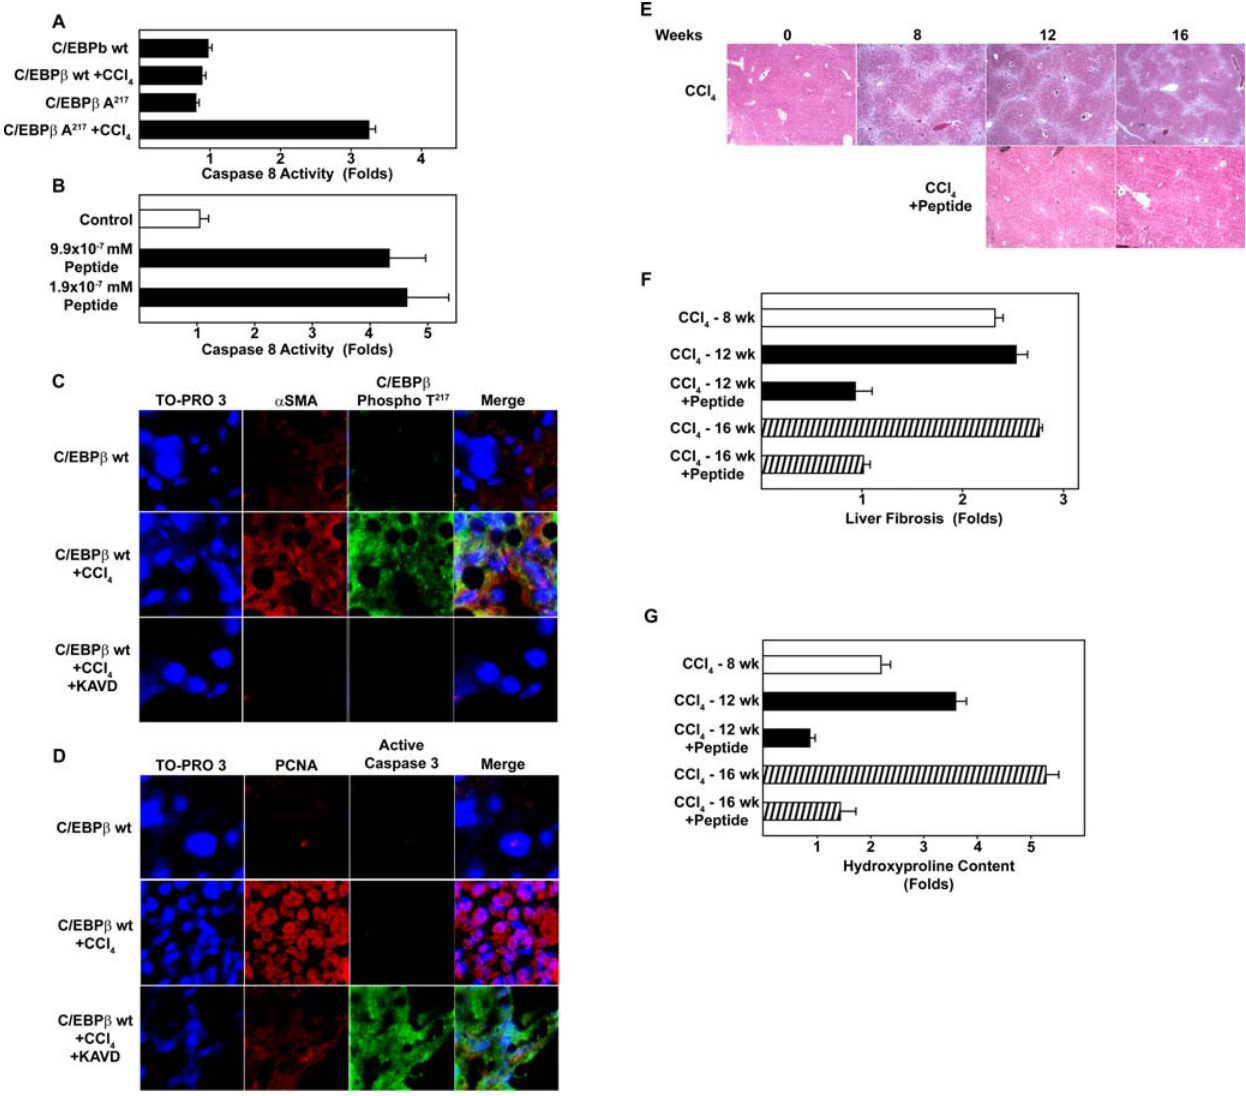
Figure 8. The RSK-inhibitory peptide blocks hepatic stellate cell activation and liver fibrosis induced by CCl 4 . A Caspase 8 activity was measured in lysates from HSC isolated from C/EBP b + / + [wt] and C/EBP b -Ala217 mice untreated or treated with CCl 4 for 24 hr. Caspase activity was increased in C/EBP b -Ala217 mice treated with CCl 4 . Results from triplicate samples of two independent experiments are shown. B. Caspase activation in a cell-free system was determined as described in Methods. The Ac-KAla217VD-CHO peptide enhanced the activation of caspase 8 at picomolar concentrations. Baseline caspase 8 activity was 3.8 U (100%). Results from triplicate samples of three independent experiments are shown ( P , 0.01 for the Ac- KAla217VD-CHO peptide). C. Animals received a single injection of CCl 4 or mineral oil as described in Methods. a -SMA (red) and C/EBP b - PhosphoThr217 (green) were identified as described in Materials and methods. Treatment with the cell permeant Ac-KAla217VD-CHO peptide blocked the expression of a -SMA and C/EBP b -PhosphoThr217. D. PCNA (red) and active caspase 3 (green) were identified as described in Materials and methods. Treatment with the Ac-KAla217VD–CHO peptide blocked the expression of PCNA and induced active caspase 3. E. C/EBP b + / + (wt) mice with severe liver fibrosis after treatment with CCl 4 for 8 weeks, while continuing on CCl 4 , received the RSK inhibitory peptide (5 m g IP, three times/ week, for week 9 followed by 1 m g IP, three times/week for weeks 10–12 or 10–16). These are representative Mallory’s trichrome stain for liver fibrosis (in blue). All control mice ( n : 8 at 8-weeks; n : 8 at 12-weeks; and n : 8 at 16-weeks) developed severe liver fibrosis, while mice receiving the RSK-inbitory peptide ( n : 8 at 12-weeks; and n : 8 at 16-weeks) had no fibrosis or only minimal liver fibrosis ( P , 0.01 ). F. Analysis of hepatic collagen content by the Sirius red collagen–binding assay showed a , 2.5 to 3-fold increase in C/EBP b + / + mice treated with CCl 4 ( n : 8 for 8 weeks; n : 8 for 12 weeks and n : 8 for the 16 weeks), compared to animals also receiving the RSK-inbitory peptide ( n : 6 for 12weeks; n : 8 for 16 weeks; P , 0.01 ). G. Analysis of hepatic collagen content by the hydroxyproline assay, showed a 2.2-, 3.5- and 5.3-fold increase in C/EBP b + / + mice treated with CCl 4 , respectively ( n : 8 for 8 weeks; n : 7 for 12 weeks and n : 7 for the 16 weeks), compared to animals also receiving the RSK-inbitory peptide ( n : 6 for 12weeks; n : 8 for 16 weeks; P , 0.01